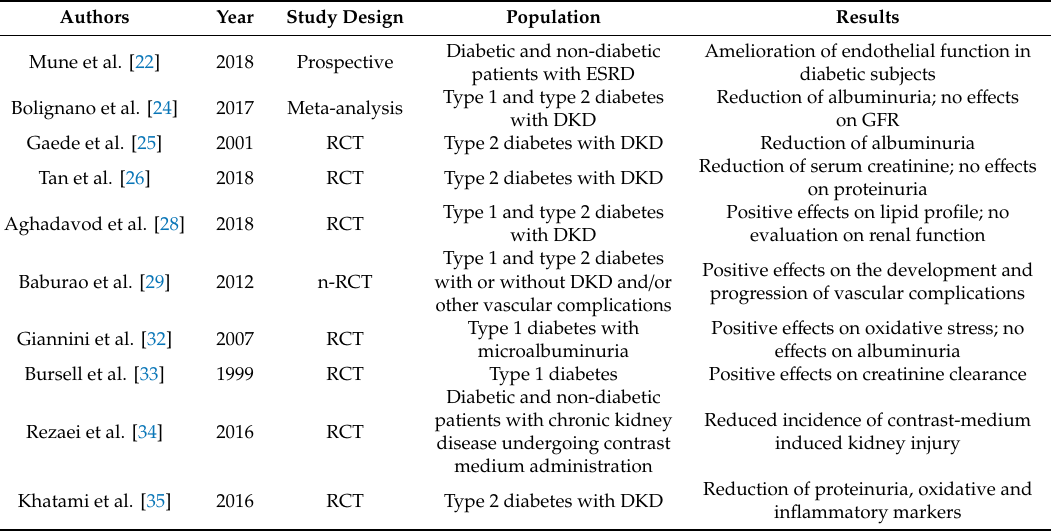
Table 1. Studies evaluating the e ff ects of vitamin E supplementation on diabetic patients with renal